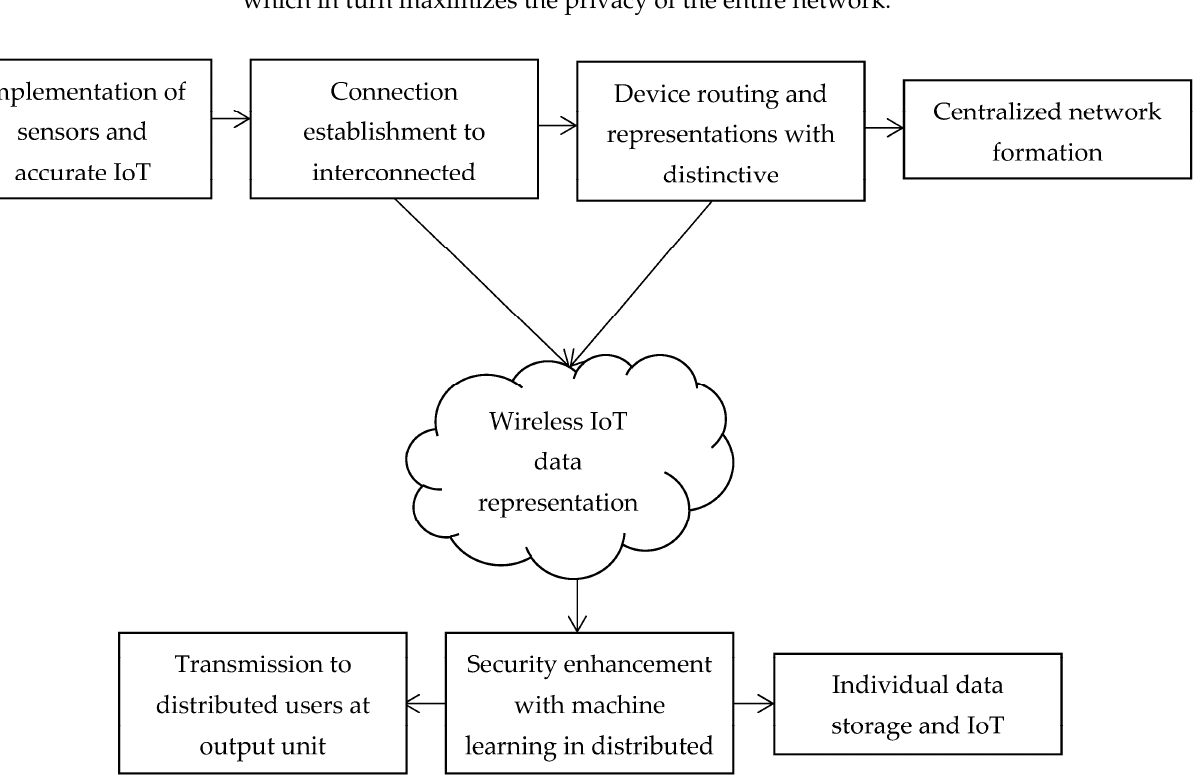
Figure 1. Flow and security enhancement in IoT data